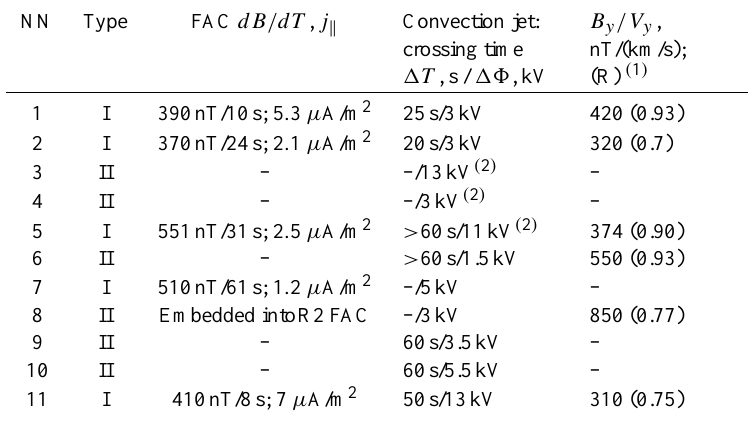
Table 2. Streamer-related field-aligned currents and convection (continuation of Table